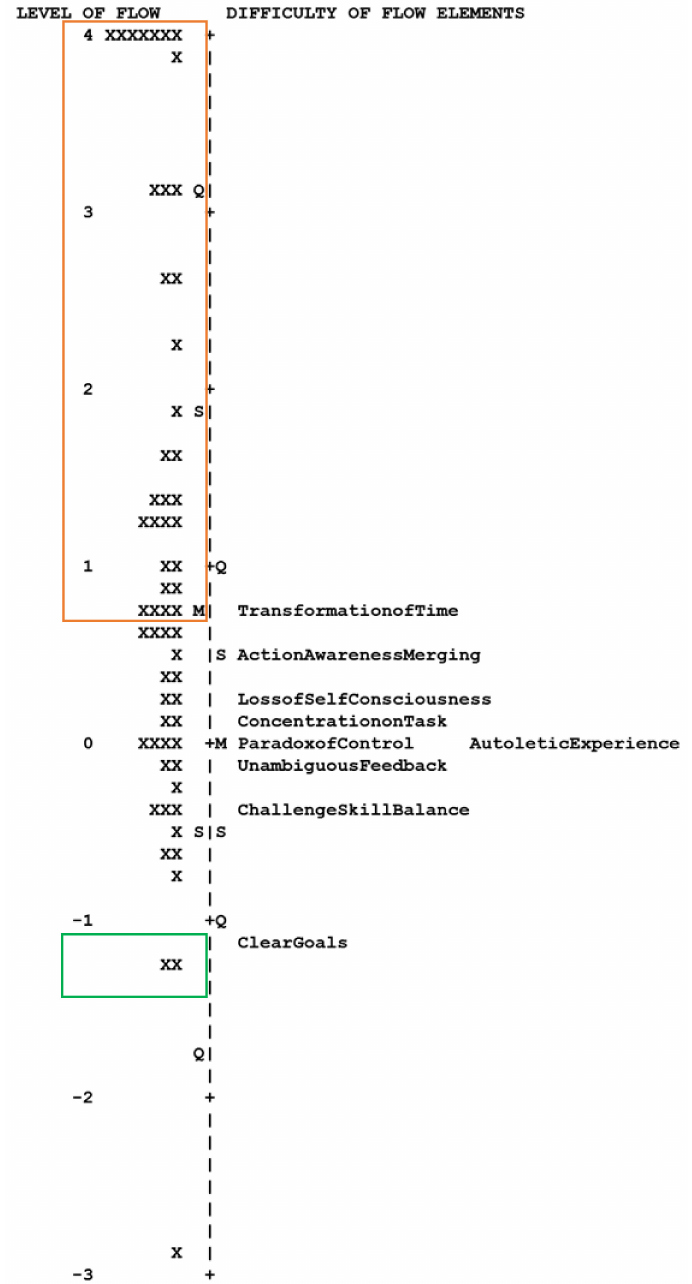
Figure 1. A map of the level of flow achieved during a task and the difficulty level of the nine flow elements on the Rasch logit scale. The green box indicates activities by participants achieving no flow and the orange box indicates activities that achieved full flow according to the Rasch Model. Activities between the boxes indicate partial